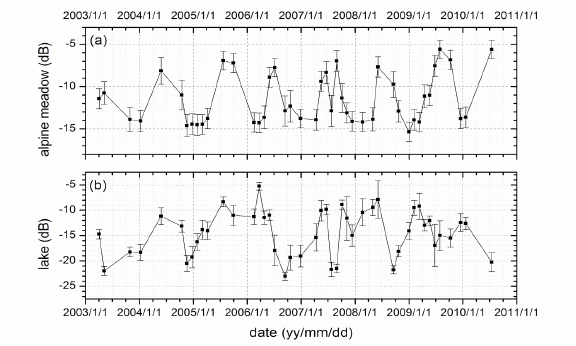
Figure 5. Time series σ 0 observed by SAR over (a) alpine meadow and (b) thermokarst lake from Apr. 2003 to Jul. 2010. arranged vertically in the direction of ice growth. If the vertical spherical bubble strings are classified as ‘cylindrical bubbles’ approximately, the slenderness ratio will varies within 100-200. The porosities range from 2% to 3% and it decreases rapidly with the depth until a constant value while the distribution of DB is uniform. (2) rachis-shaped bubbles (RB) in central lake ice cover (Figure 4(c) and (d)). The individual RB has a relatively large size and a regular pattern of oblate round cake or quasi-sphere of 1-5 cm diameter and 1-2 cm height, with a flat top and a circular bottom. All these units are vertically connected in series with a pronounced horizontal banding, which is similar to “kotenoks” described by (Walter et al. 2008; Wu et al. 2014). Both the porosity of ice and the mean size of these bubbles increase with lake depth and thus the density profile of ice is also